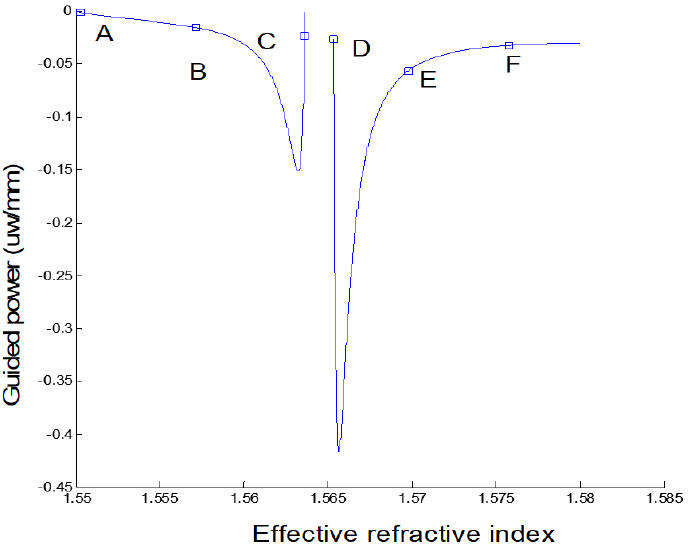
Figure 4. Dispersion curve of three-layer metamaterial waveguide with nonlinear cladding and substrate at d f = 5 μ m.